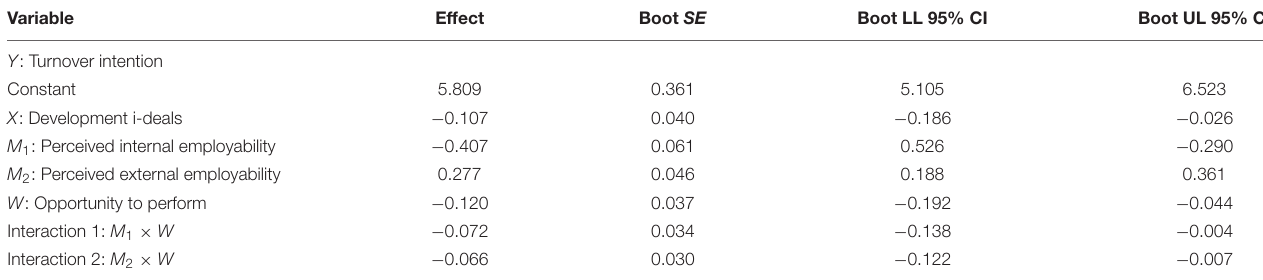
TABLE 4 | Moderating effect of opportunity to perform on the relationship between perceived employability and turnover intention.